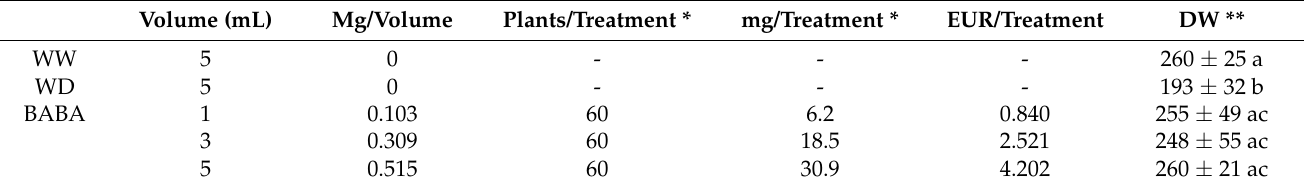
Table 3. Seedlings DW (Dry Weight mg), BABA (mg) and costs (EUR) analysis per treatment depending on the volume (ml) used in the experiments. Different letters represent significant differences between